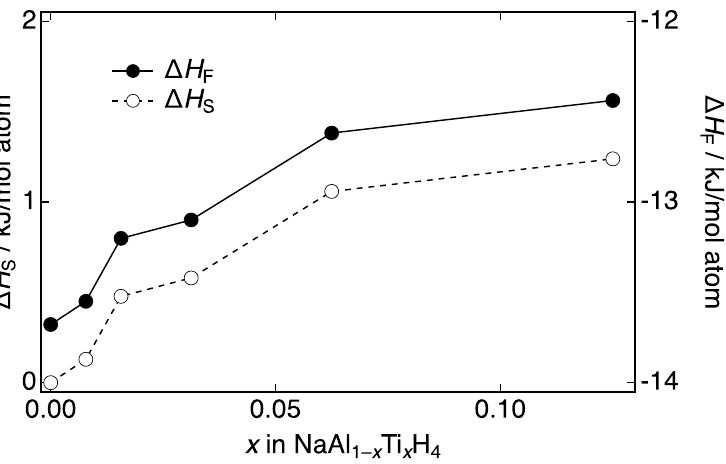
Figure 8. Variations of the enthalpy of formation, Δ H F , and the heat of substitution, Δ H S , as a function of the Ti content in doped NaAlH 4 .